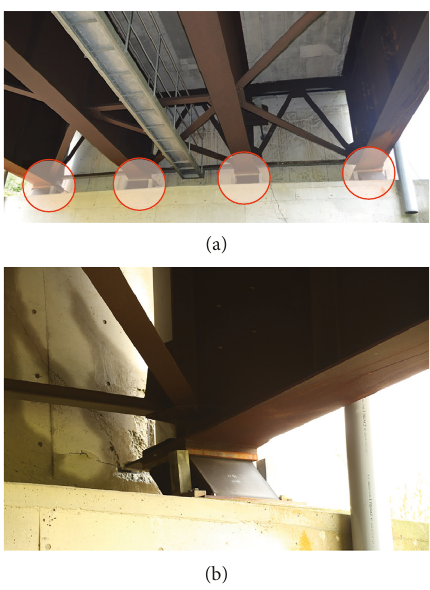
Figure 16: Damage to the dampers at abutment A1 (interior).